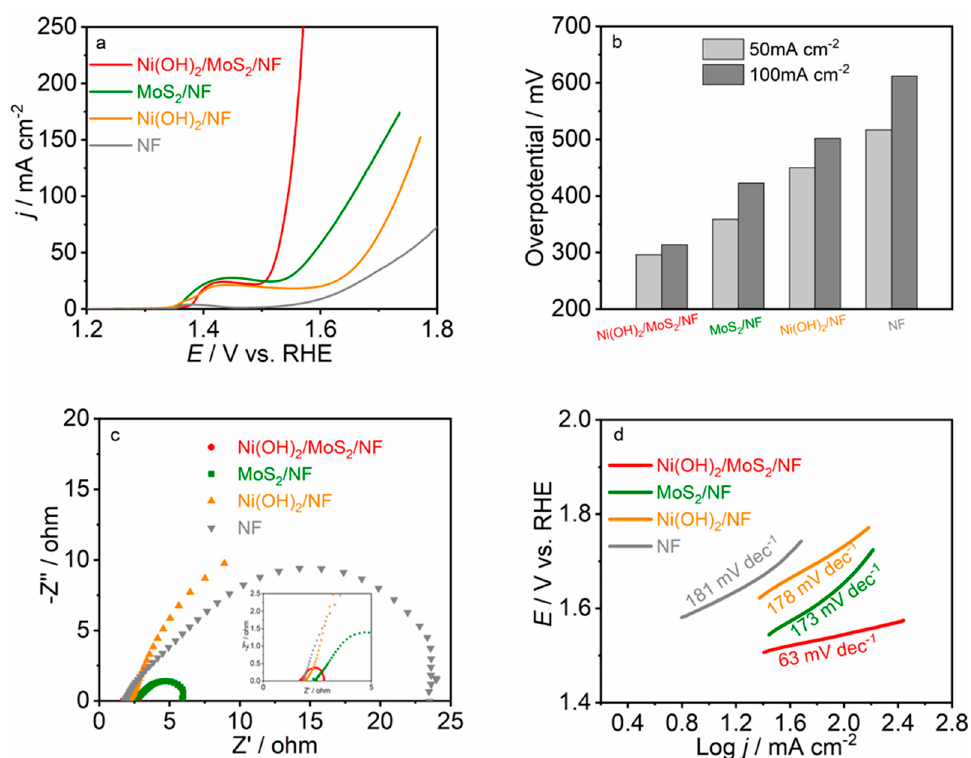
Figure 4. ( a ) The iR-corrected polarization curves ( b ) a comparison of the corresponding overpotentials at 50 mA·cm − 2 and 100 mA·cm − 2 current outputs, ( c ) the electrochemical impedance spectroscopy ( d ) corresponding Tafel plot of the Ni(OH) 2 /MoS 2 /NF, MoS 2 /NF, Ni(OH) 2 /NF and bare NF electrodes.